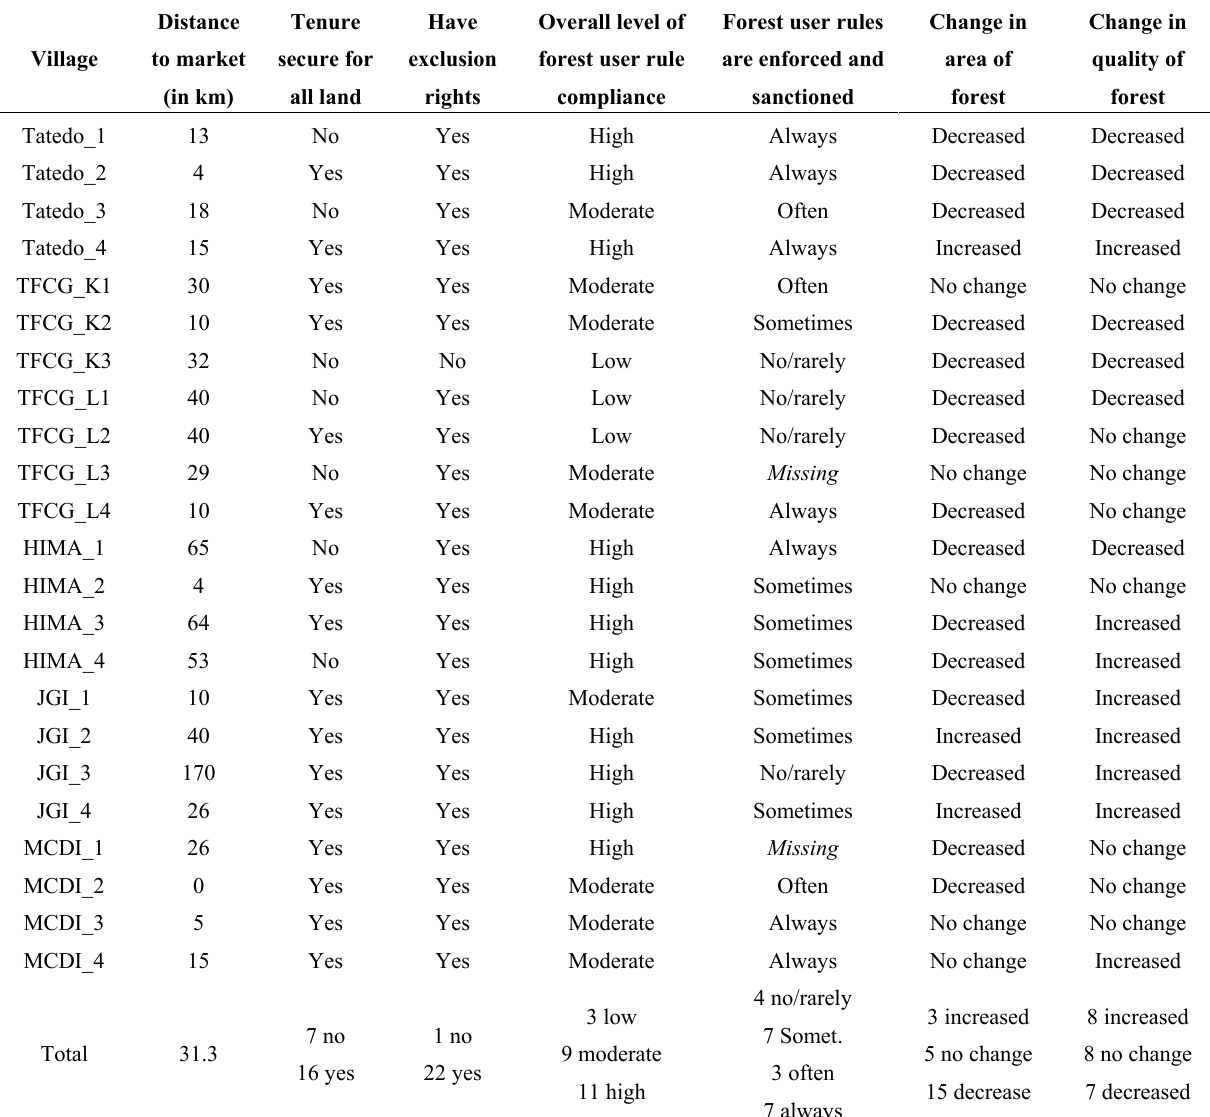
Table 3. Overview of Study Villages. Market Access, Institutions and Rules, and Perceived Changes in Forest Cover and